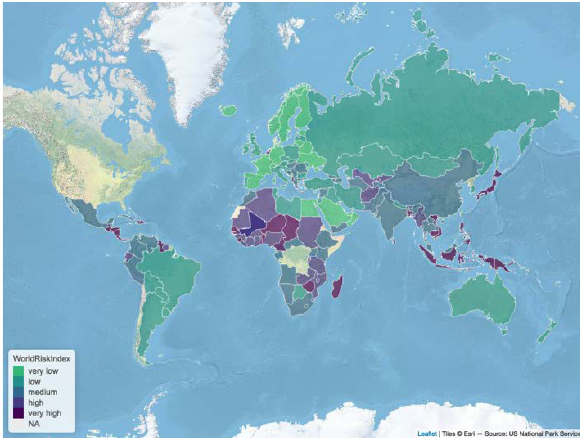
Figure 11. Vulnerability of the Open Risk Index Figure 11 in comparison is the original World Risk